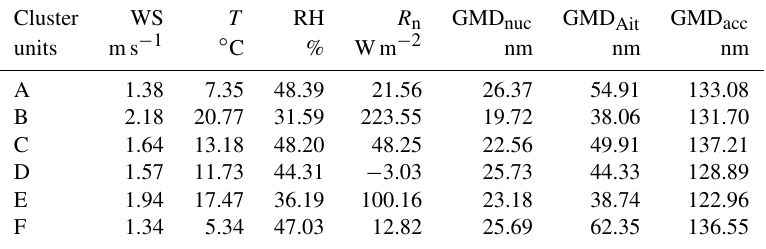
Table 3. Mean values of meteorological parameters (wind speed, temperature, relative humidity and net radiation) and geometric median diameters (GMD nuc , GMD Ait and GMD acc are for nucleation, Aitken and accumulation modes) fitted by Eq. (1) for each cluster. WS, T , RH and R n are the abbreviations of wind speed, temperature, relative humidity and net radiation,